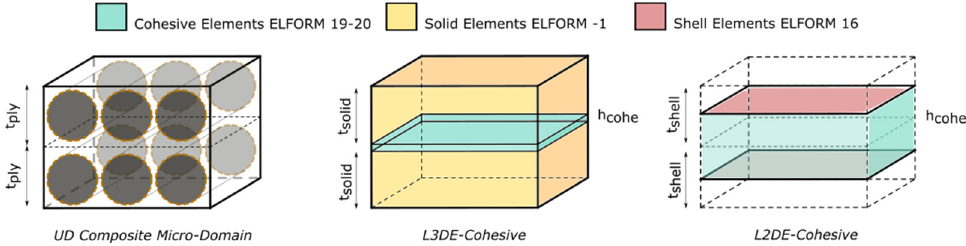
Figure 6. Schematic representation of different FEM-Cohesive models [11].